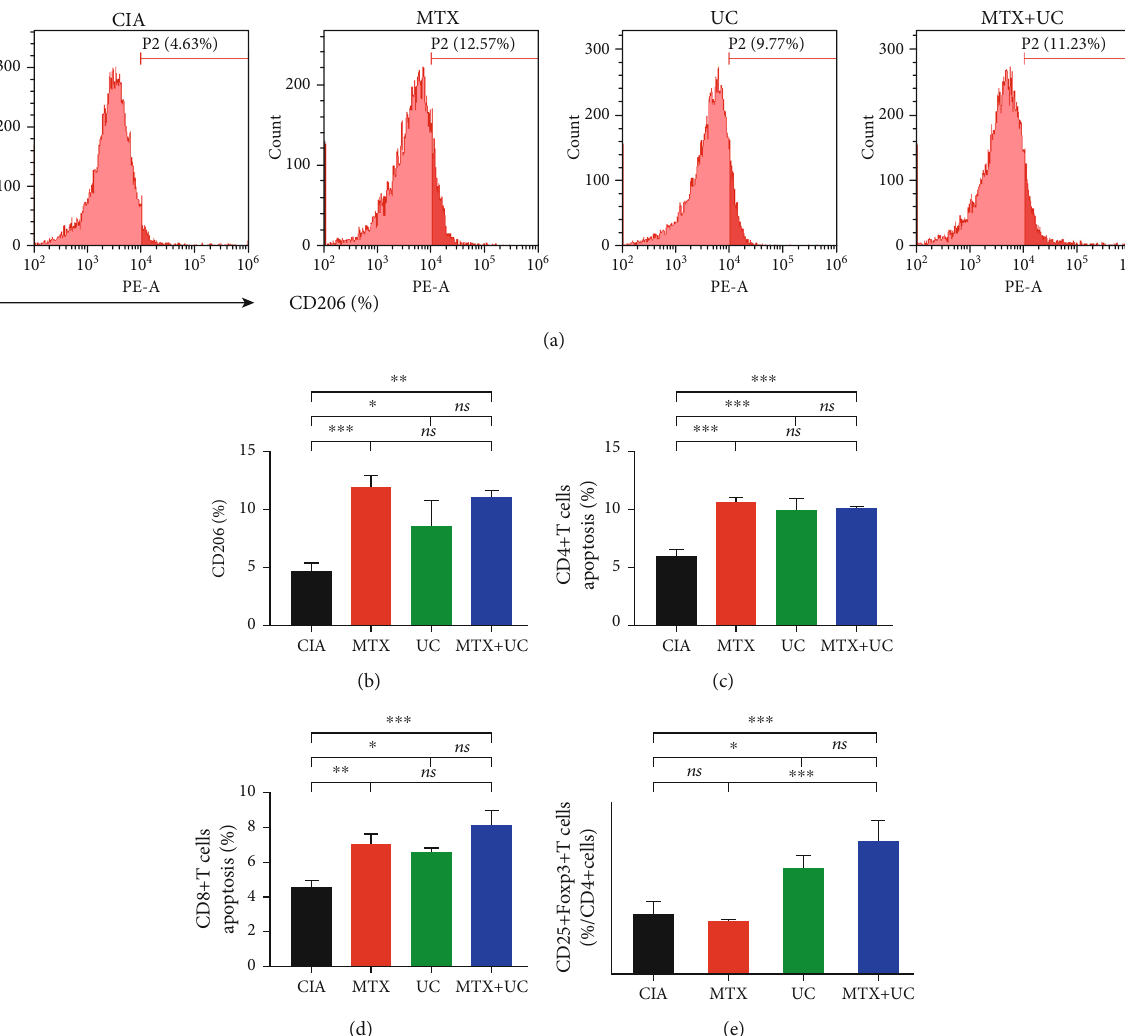
Figure 4: Combination of UCs and MTX promoted peritoneal macrophage polarization and enhanced the population of spleen Tregs in CIA mice. (a) Flow cytometry analysis of the proportion of M2 polarization in peritoneal macrophages marked by CD206. (b) The quanti fi cations of CD206 macrophages after treatment. (c, d) The apoptosis of CD4+ and CD8+ spleen T cells was analyzed by fl ow cytometry. (e) The population of spleen Tregs marked by CD4+, CD25+, and Foxp3 was analyzed. n = 3 per group. Data are shown as mean ± SD . ∗ P < 0 : 05 ; ∗∗ P < 0 : 01 ; ∗∗∗ P < 0 : 001 ; ns: not signi fi cant ( P > 0 : 05